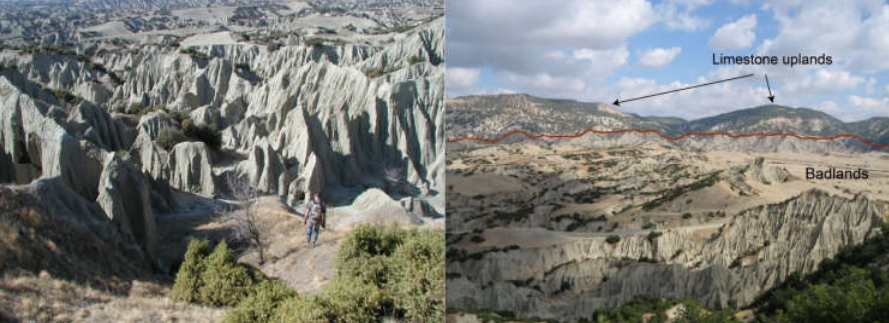
Figure 2. General view of the badland topography and extensively eroded surface features. Red line differentiates the badlands from the limestone uplands (right).